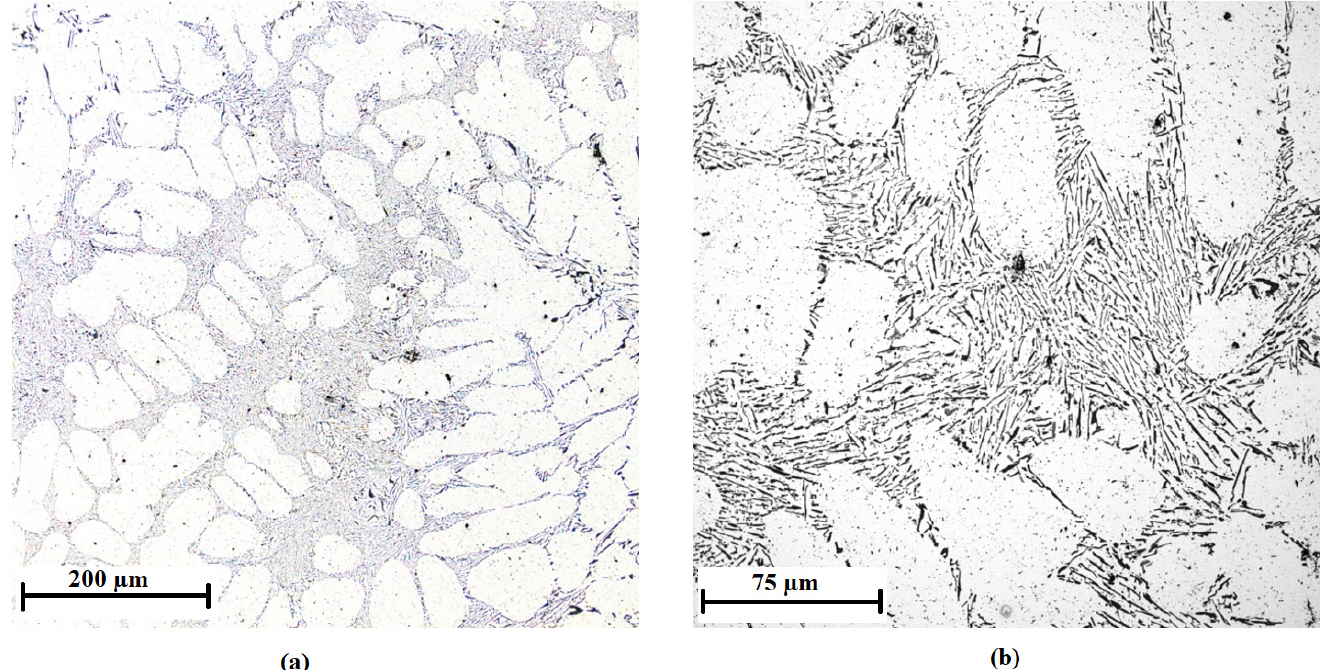
Figure 12. Microstructure of the AlSi7Mg0.3 alloy with the addition of 0.05 wt % AlTi5B1: ( a ) low- magnification overview, ( b ) detail.